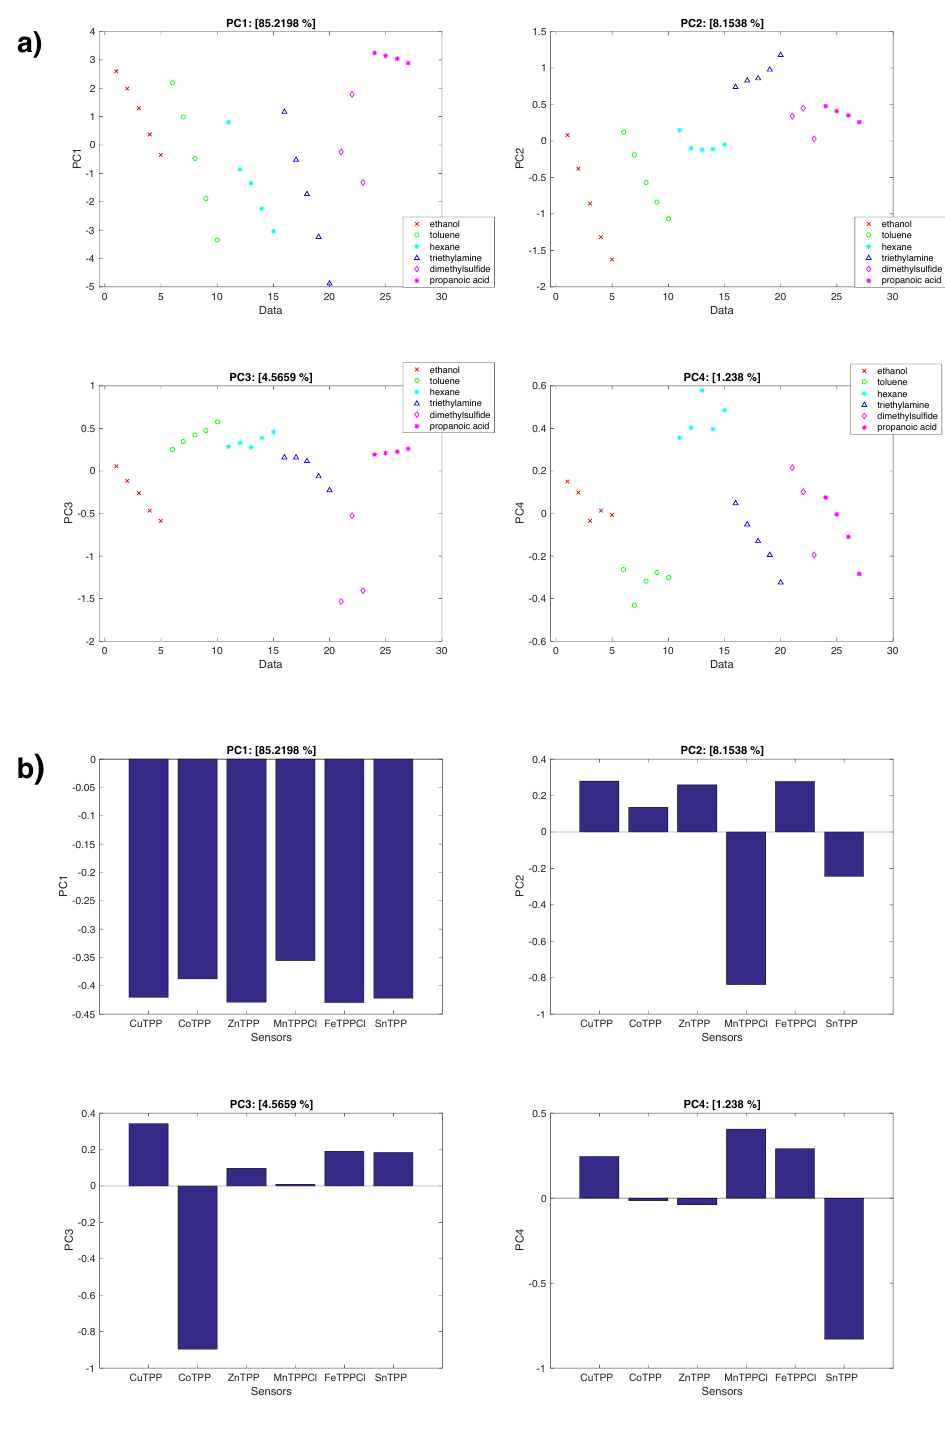
Figure 5. Results of the PCA of the sensors data. ( a ) Scores of the first four principal components; ( b ) Loadings of the first four principal